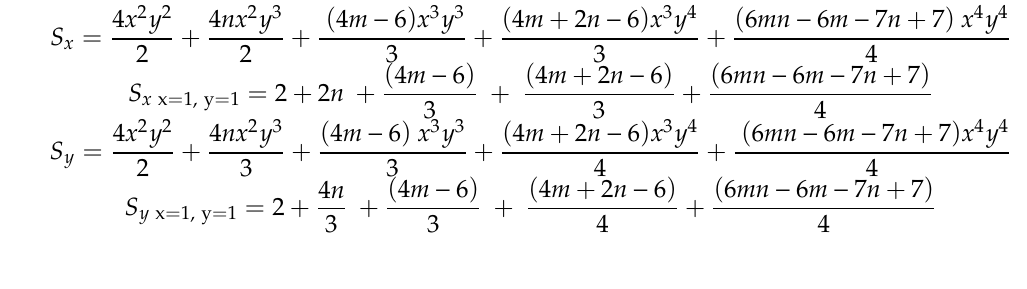
Table 2. The relation between topological indices and M-polynomial.